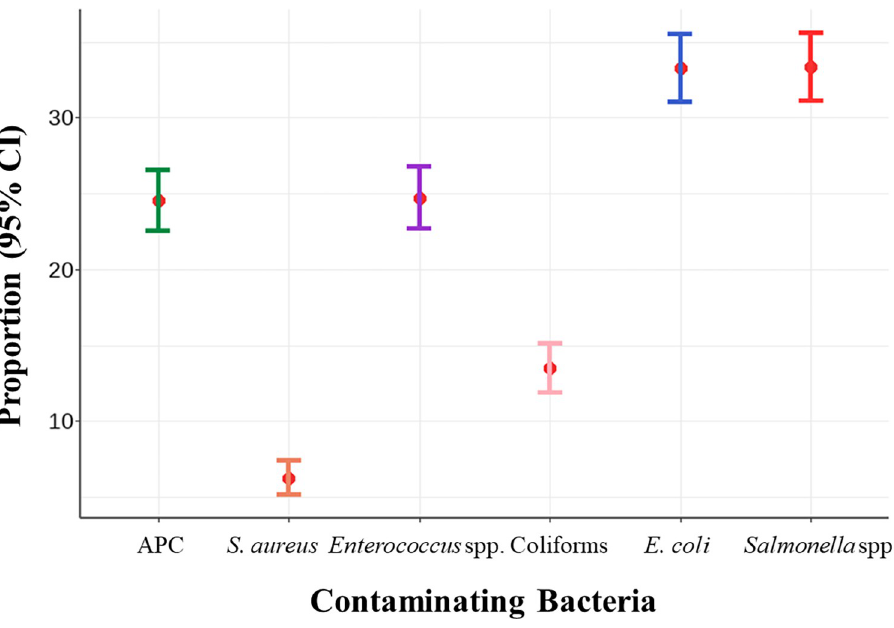
Fig 2. Proportion and 95% confidence interval (95% CI) of non-compliant meat samples according to the Department of Livestock Development criteria.